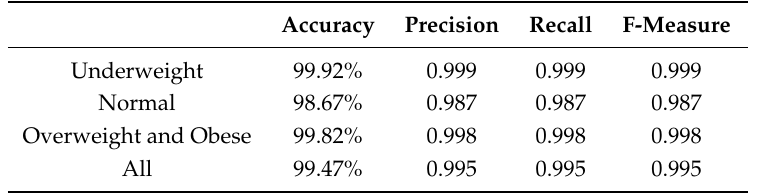
Table 9. Results with different BMI values without considering the BMI feature.